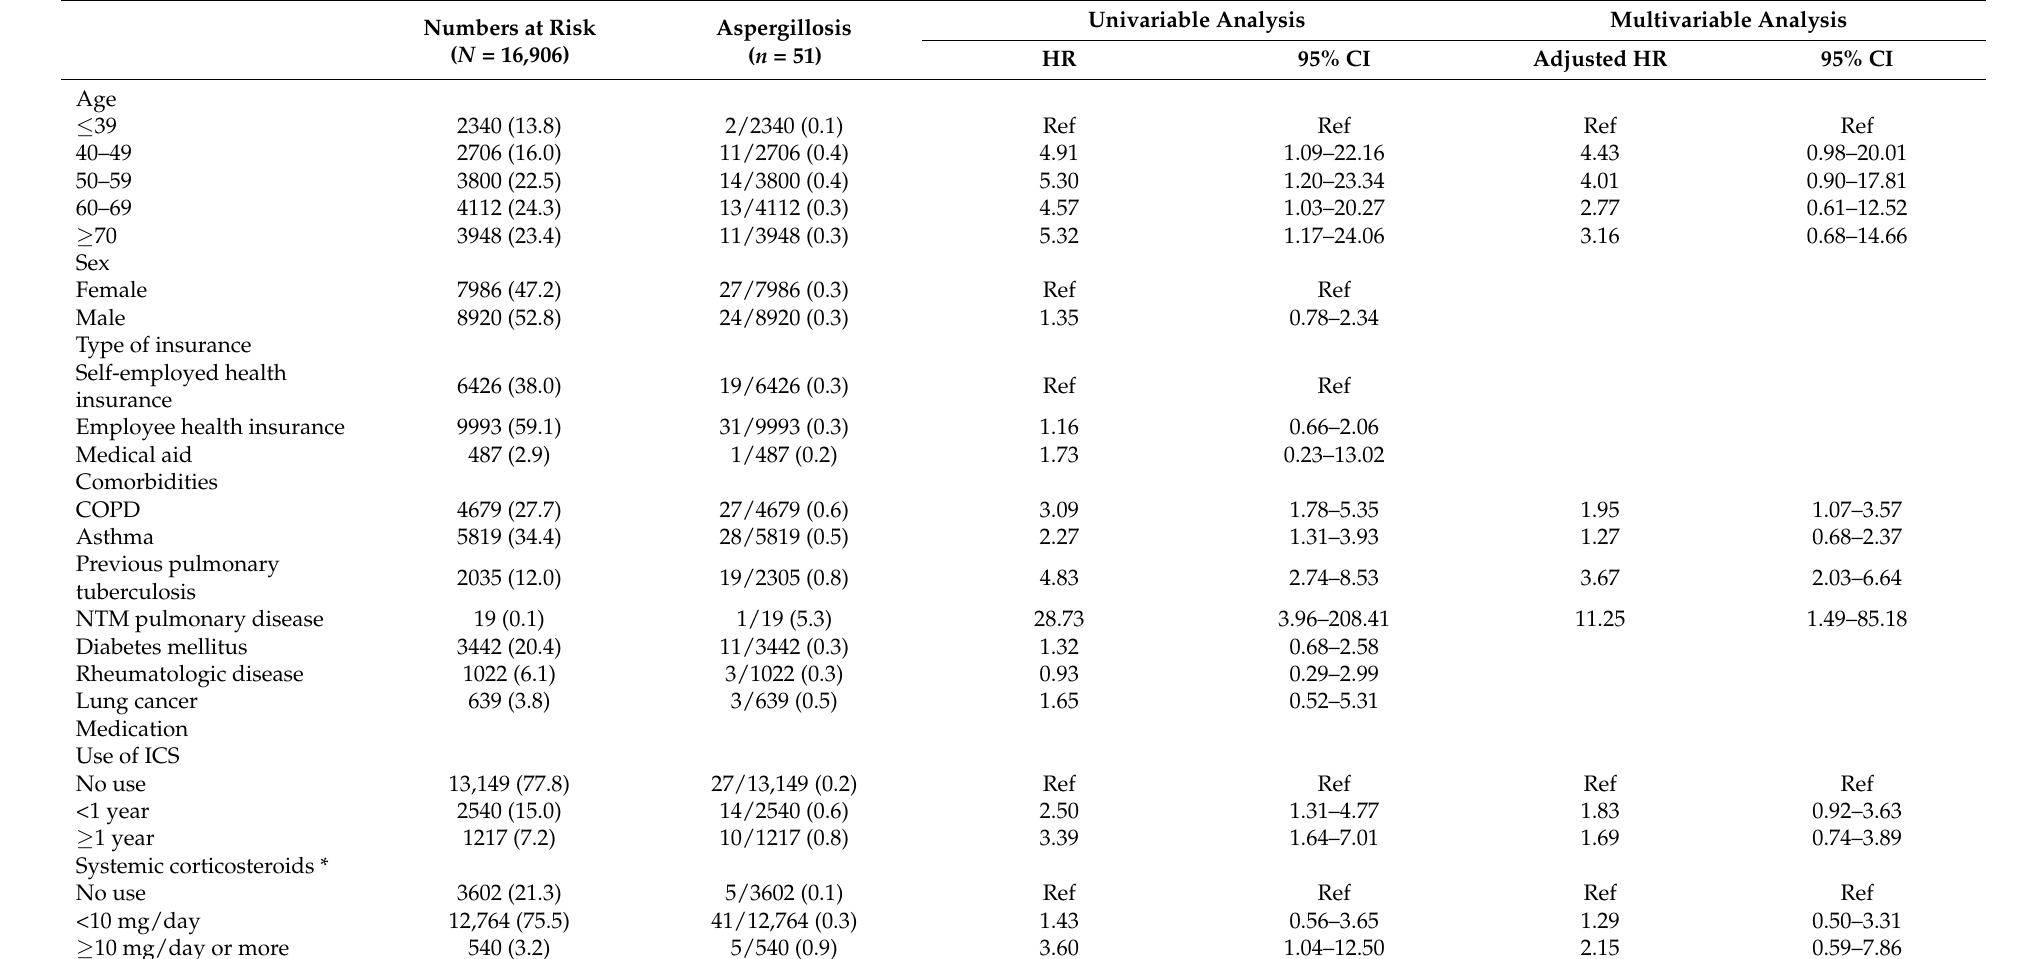
Table 3. Risk factors for aspergillosis in patients with